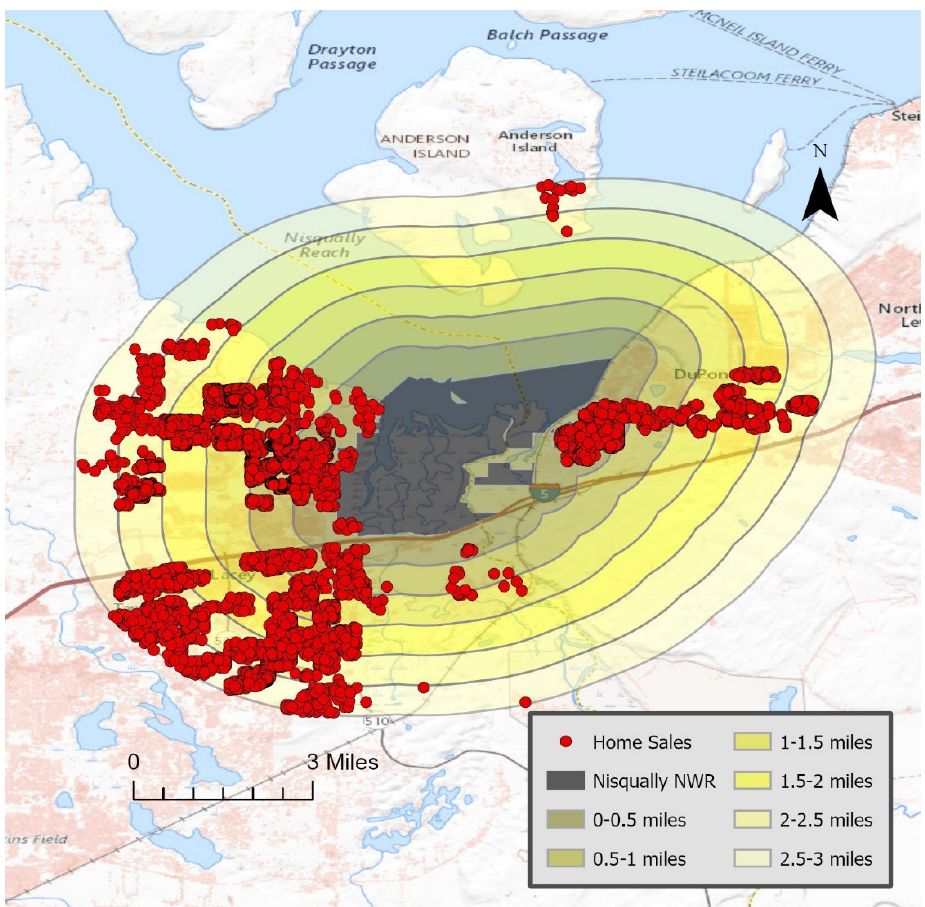
Figure 2. Study area in Pierce and Thurston Counties in Washington state in the United States. Includes 6528 property sales from 2005–2015 and the area of the Billy Frank Jr. Nisqually National Wildlife Refuge (NNWR). Table 1. Description of hedonic pricing model